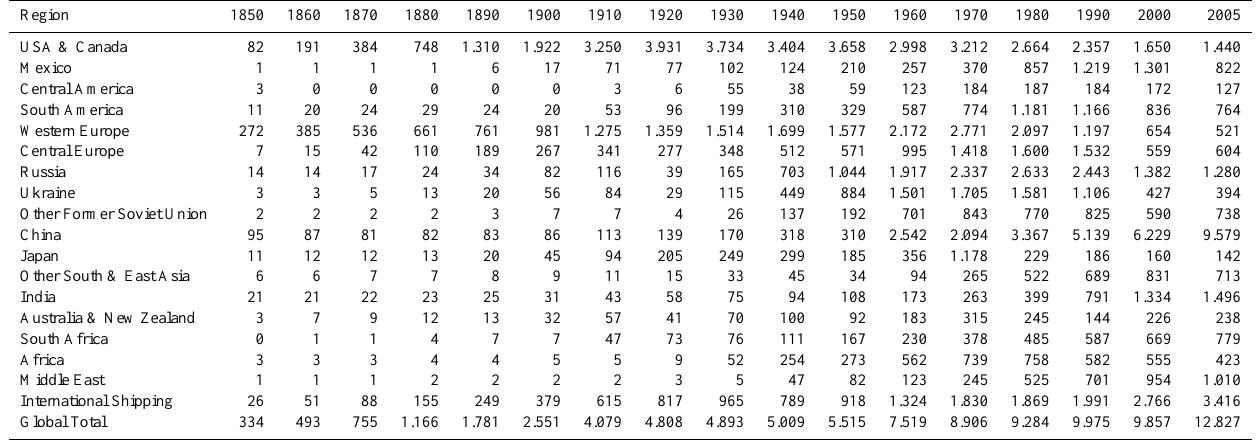
Table 3. Estimated emissions uncertainty, as 5–95% confidence interval, for the indicated year and region (GgSO 2 ) .